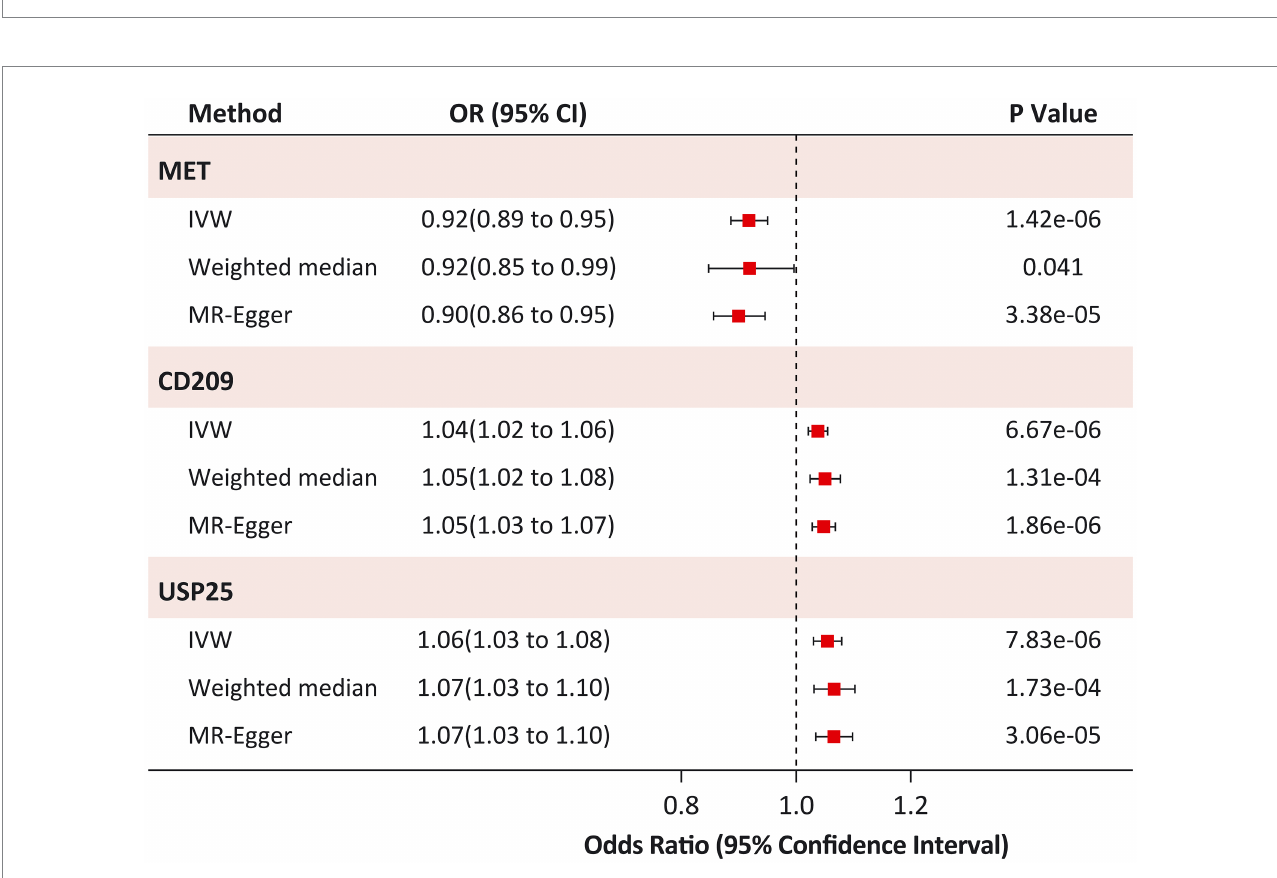
FIGURE 2 Effects of genetically predicted plasma proteome on HF. The red solid line represents the Bonferroni-corrected significant threshold of p = 1.52 × 10 − 5 . The black dotted line represents the suggestive association threshold of p = 0.05. HF, heart failure.